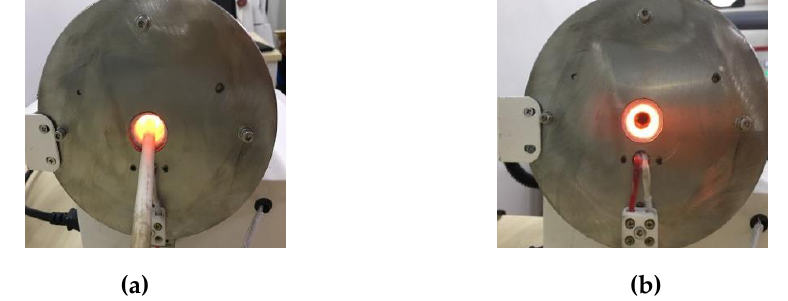
Figure 9. Static thermal test rig scheme (1—sensor, 2—heating rod, 3—insulating layer, 4—thermocouple).